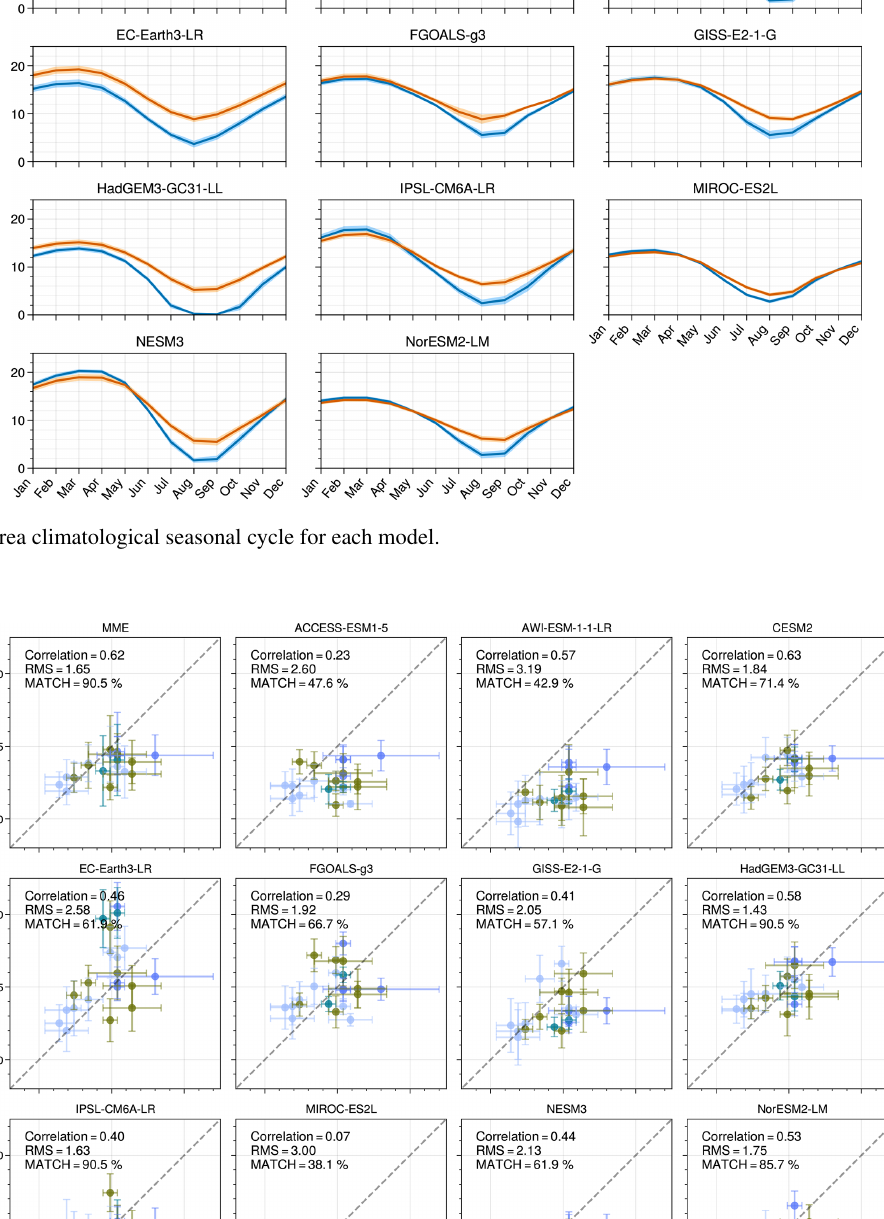
Clim. Past, 19, 883–900, 2023